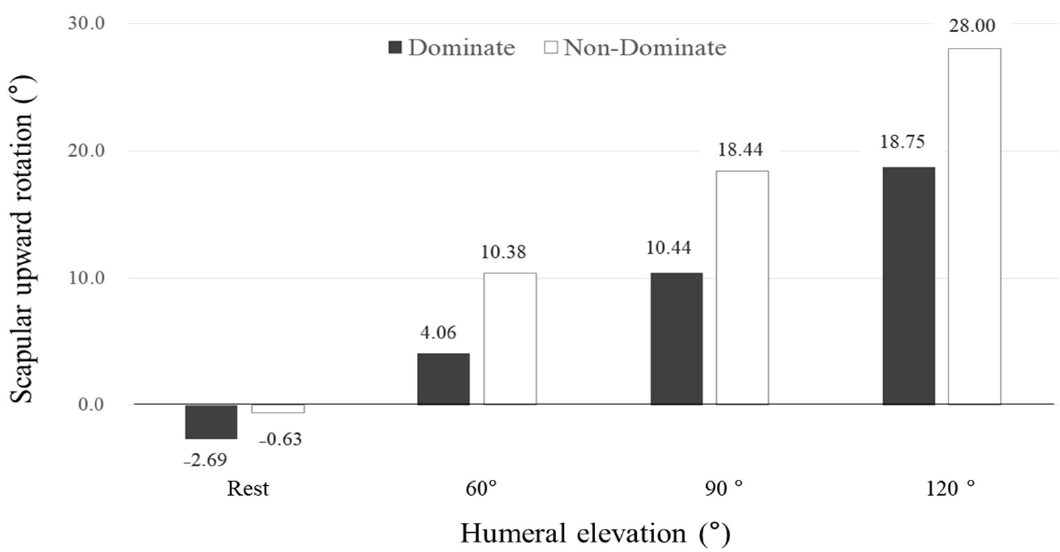
Figure 2. Scapular upward rotation (°) according to humeral elevation (°) in this study population.